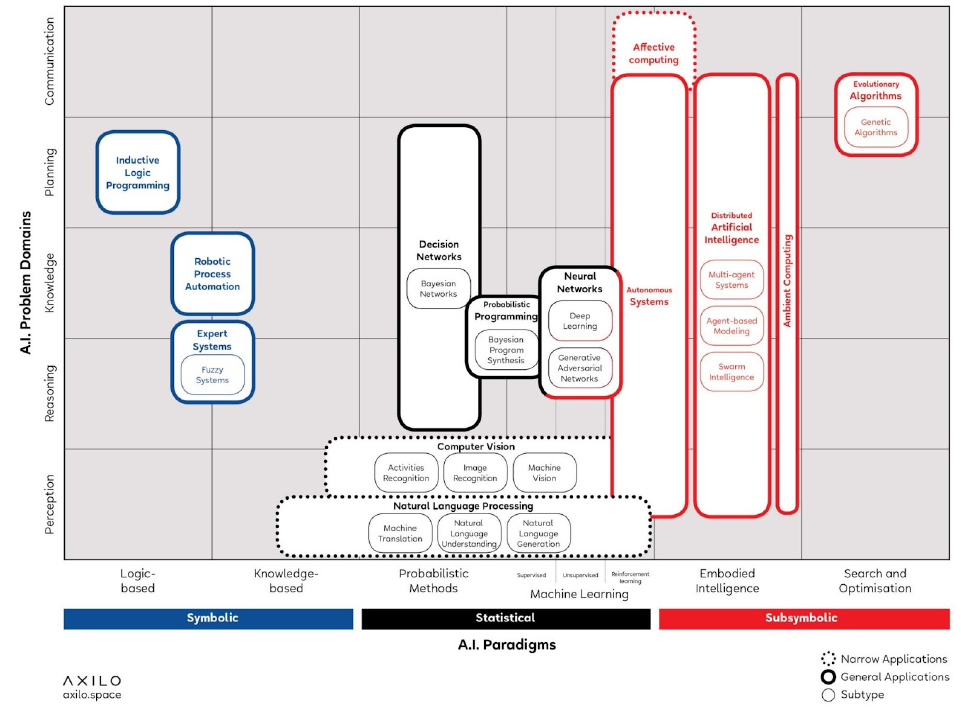
Figure 6. AI knowledge map (AIKM developed by F. Corea for the strategic innovation consultancy Axilo, for activities on their Chôra platform.).